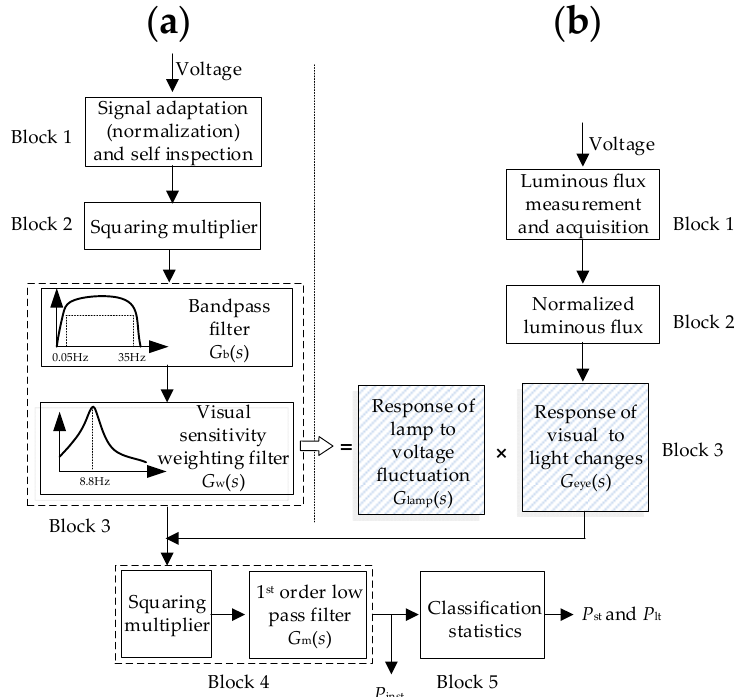
Figure 1. Relationship between IEC and the luminous flux flicker model: ( a ) IEC and ( b ) luminous flux flicker meter models.